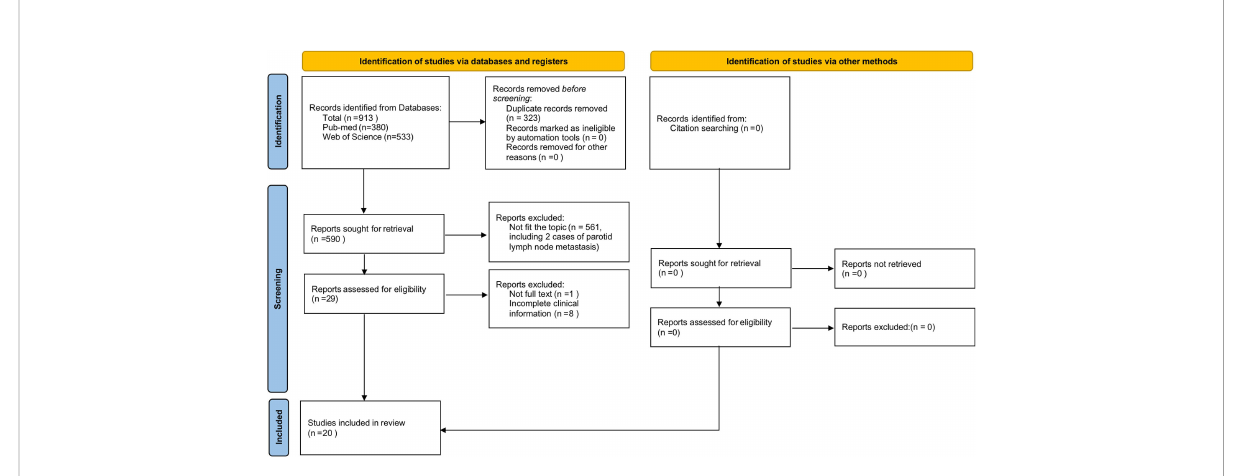
FIGURE 3 The fl ow diagram according to PRISMA shows the detailed fi ltering